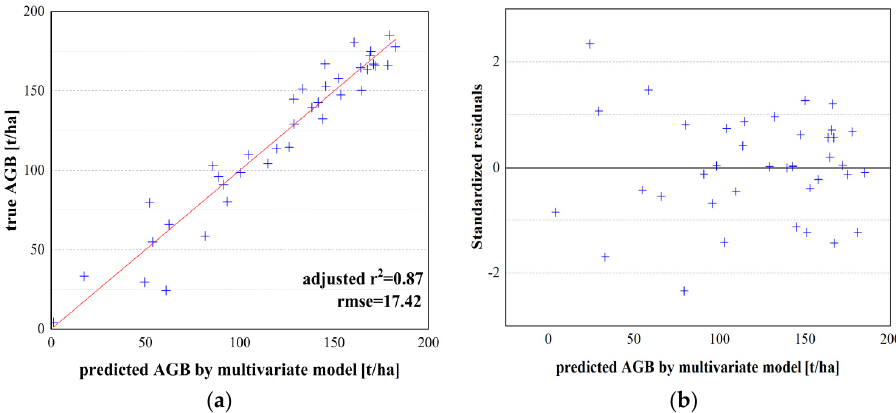
Figure 7. ( a ) Models established by all the variables that were significantly correlated; ( b ) residual analysis graph. Table 8. Collinearity analysis.